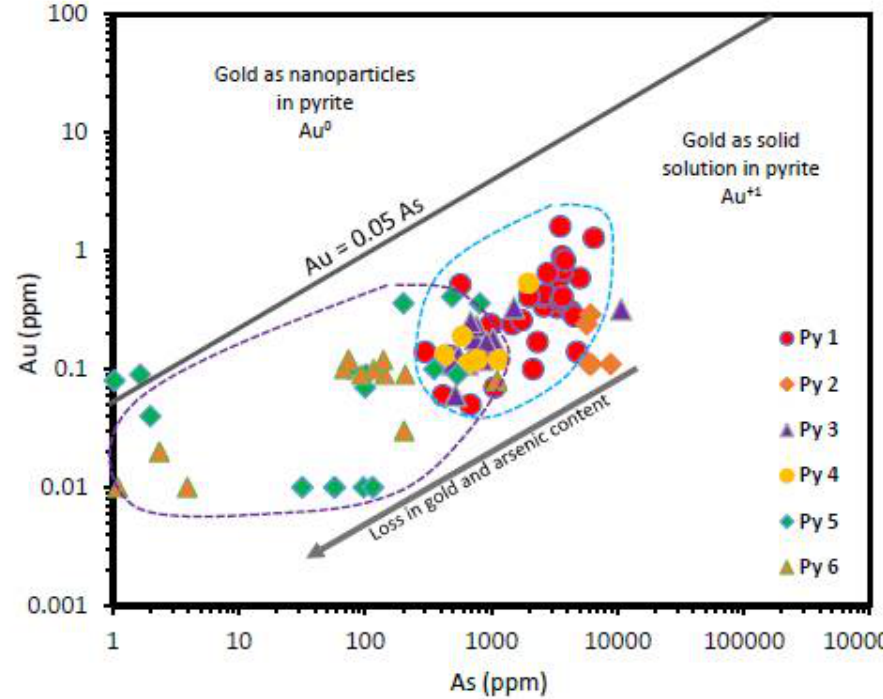
Figure 9. Au–As relationship in pyrite from the black mudstones, Langkawi, Malaysia. Au = 0.05 As is the gold saturation line for arsenian pyrite from Large et al. (2011).